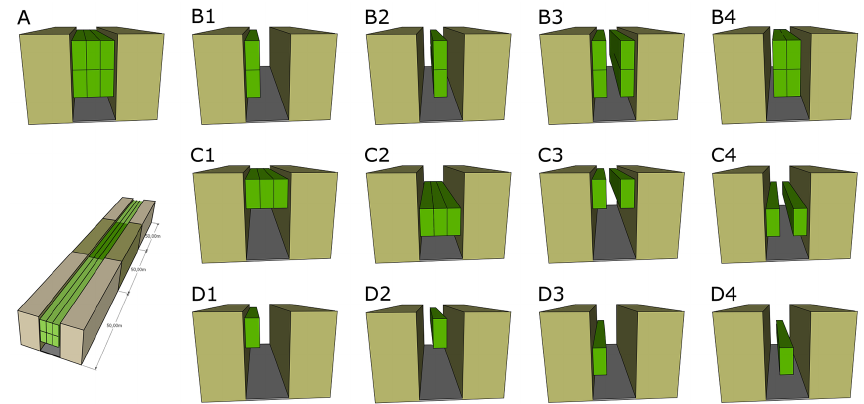
Figure 3. Description of the SOLENE mockup and presentation of the ensemble of vegetation layouts selected for the comparison between TEB and SOLENE simulations. The cases are presented here for the example of the urban canyon with h/w = 2 rescaled vegetation (see Sect. 5.2.1 and Fig. 2 for further